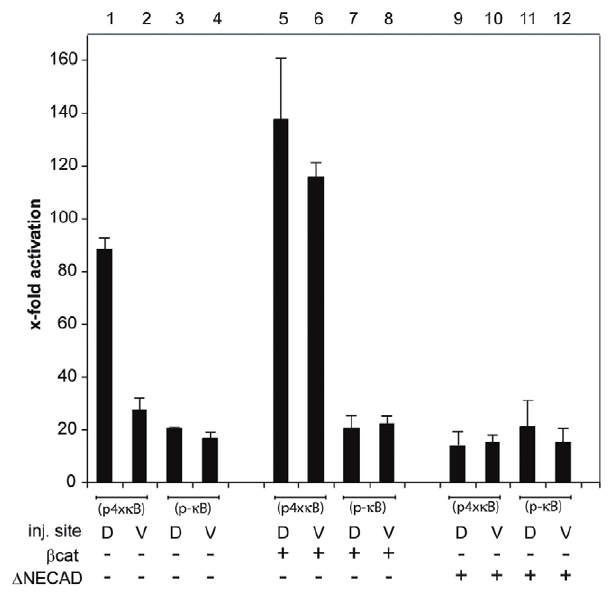
Figure 7. A synthetic NF- k B reporter gene is coactivated by b - Catenin. Luciferase activity at midgastrula (NF11) produced by injection of the reporter constructs pNF- k B + (containing 4 k B binding sites) and pNF- k B 2 (containing none) into both blastomeres of either the dorsal or ventral side of 4-cell stage embryos. b -Catenin (25 pg; lanes 5–8) and E-cad D E (50 pg; lanes 9–12) RNAs were co-injected with the reporter. Y-axis shows x-fold stimulation of luciferase activity over uninjected controls after normalization to the internal Renilla control.